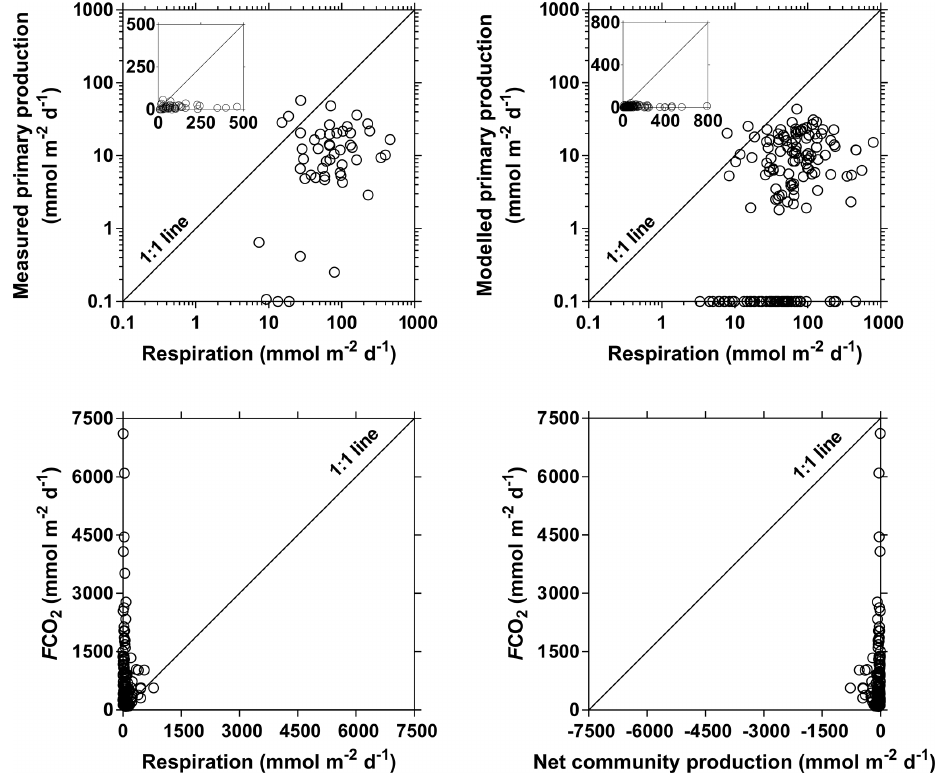
Figure 15. Primary production (measured and modeled) (mmolm − 2 d − 1 ) as a function of community respiration (mmolm − 2 d − 1 ) and air–water CO 2 fluxes ( F CO 2 in mmolm − 2 d − 1 ) as a function of community respiration (mmolm − 2 d − 1 ) and net community production (mmolm − 2 d − 1 ) in surface waters of rivers and streams of the Congo River network. Insets show the data on a linear scale (instead of a log–log